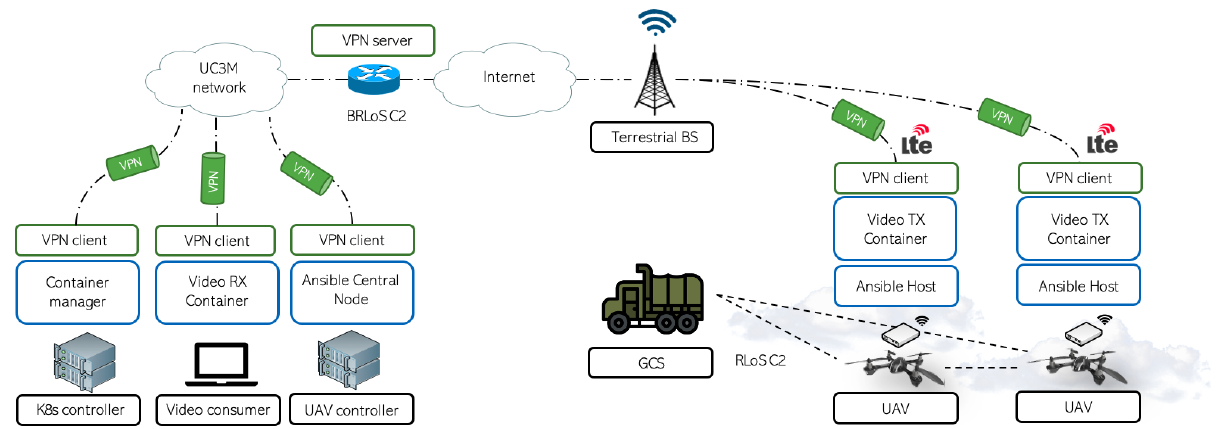
Figure 2. High overview of the proposed